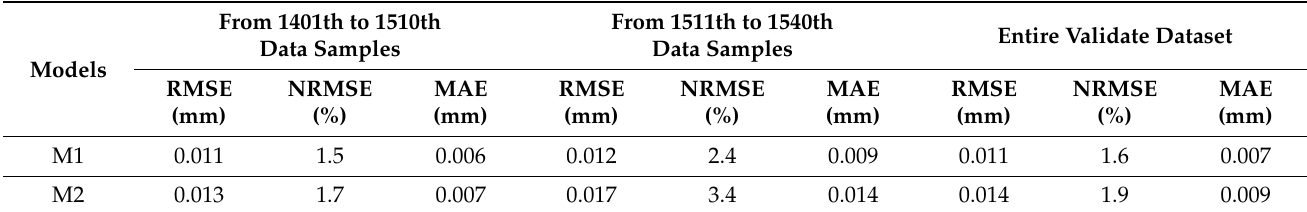
Table 8. Estimation errors of the FNDE vertical vibration in validation